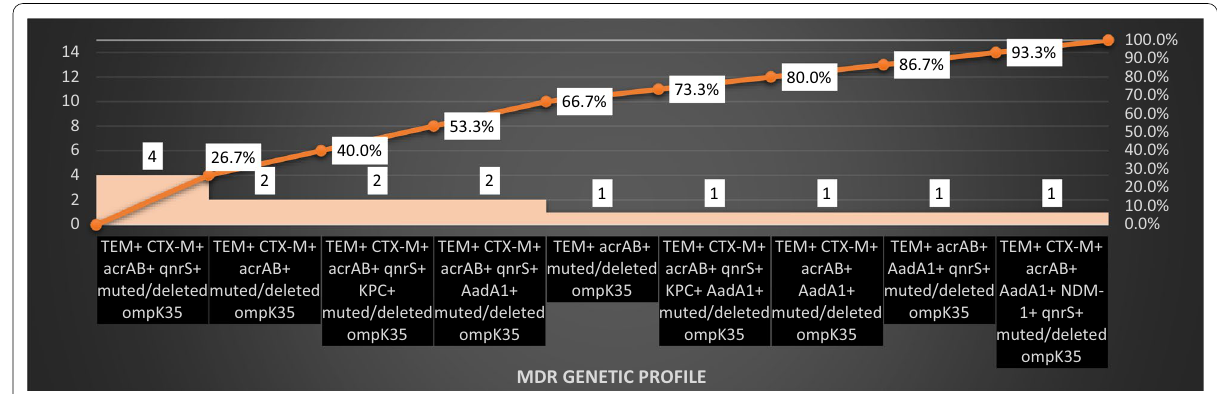
Fig. 3 Pareto Chart showing the frequency of the associated MDR determinant